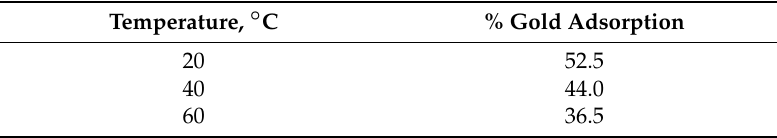
Table 3. Effect of temperature on gold(I)